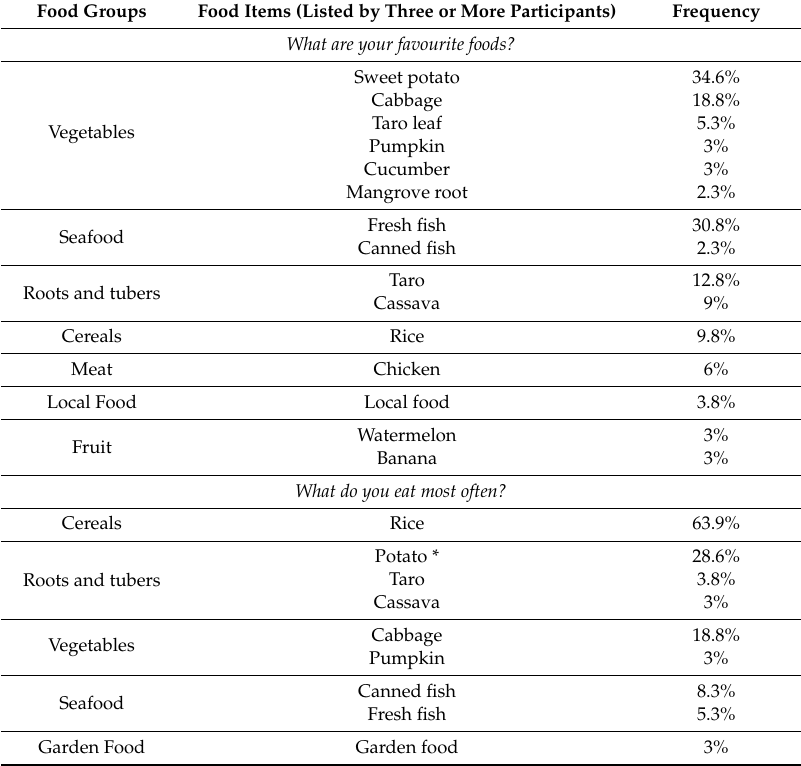
Table 4. Free listing results for “favourite food”, preference and reported frequency of “most often consumed food items” listed by three or more